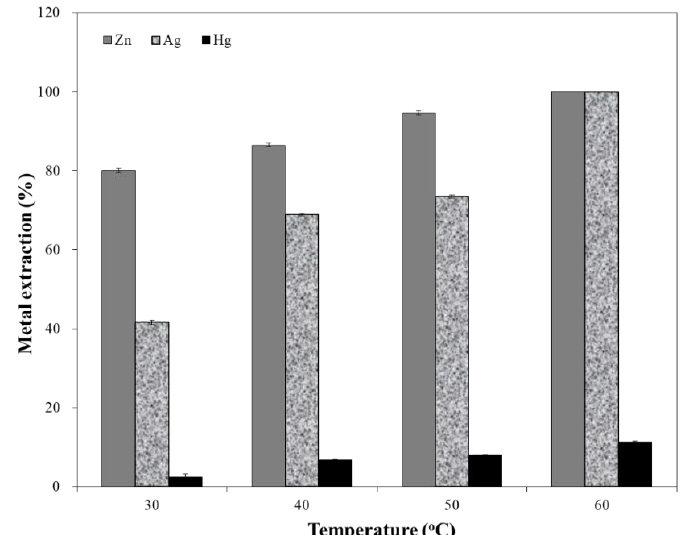
Figure 2. Effect of temperature on metal leaching using 100 mL A. niger spent medium after six hours of incubation and 150 rpm.